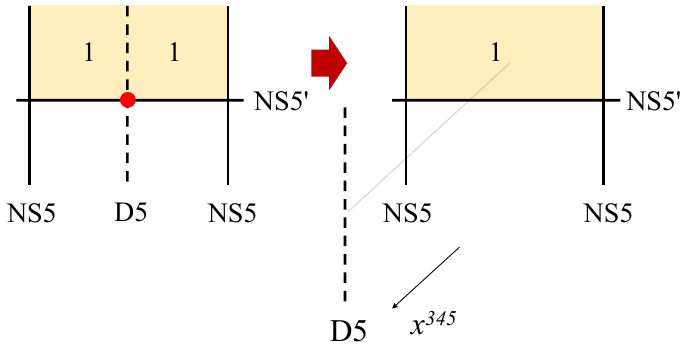
Figure 6 . Higgsing precess of Neumann b.c. (